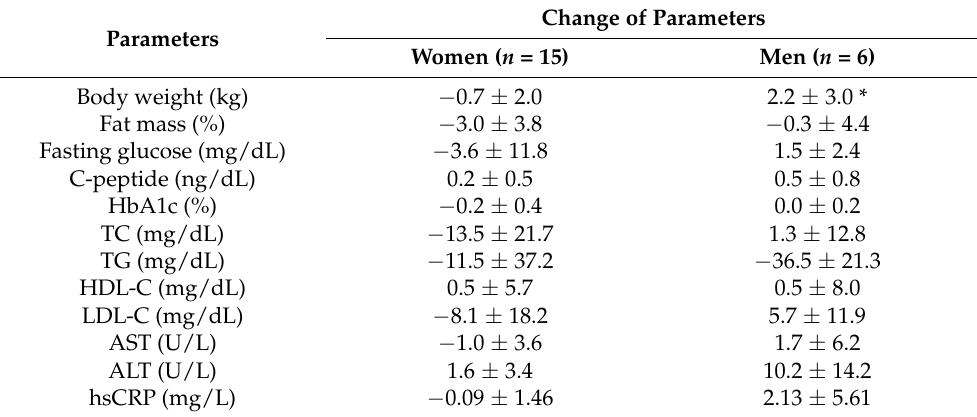
Table 2. Change in blood lipid and inflammatory parameters after the 6-week experimental period according to